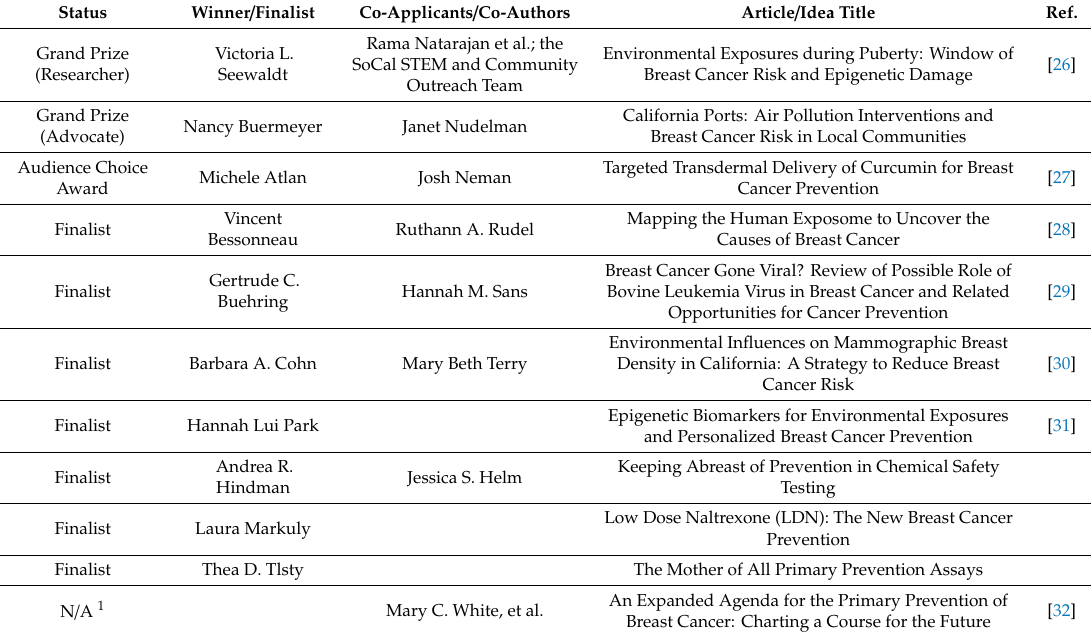
Figure 2. Photos taken at the Global Challenge Idea Showcase and Competition event. Top left: Keynote address by Susan M. Love. Bottom left: California Breast Cancer Research Program (CBCRP) Director Marion H.E. Kavanaugh-Lynch (right) poses with challenge winners Victoria Seewaldt (left), Michele Atlan (middle), and Nancy Buermeyer (right). Right: Nancy Buermeyer (grand prize, advocate) presents her idea. (Photo credits: Michael Pegram). Table 1. The winners and finalists of the Global Challenge to Prevent Breast Cancer and articles published in this Special